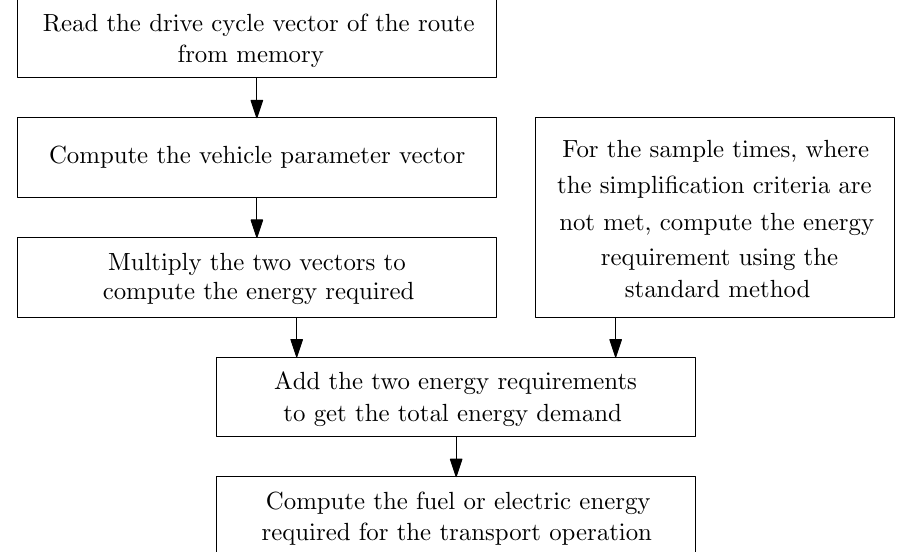
Figure 2. The algorithm to compute the total fuel or electricity requirement for a route.